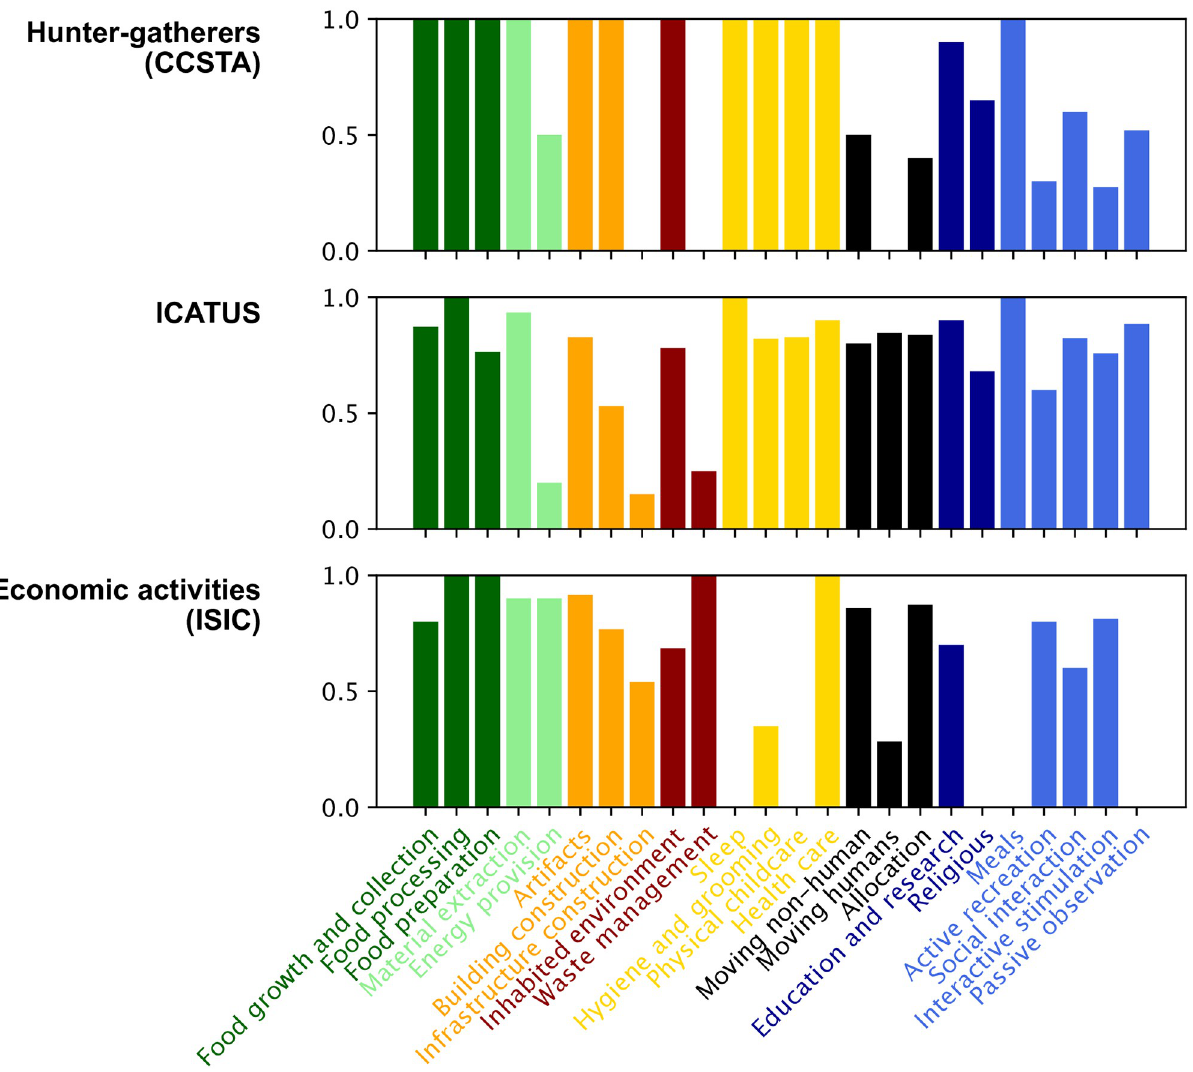
Fig 4. Average time fraction by MOOGAL category. Each bar shows the average of all time fractions associated with each category, for each of the three illustrative lexicons. Where the average time fraction is 1, only unambiguous, direct associations occurred within the category. Where the value is < 1, the association required some subdivision of activities amongst multiple categories. For example, food processing was only unambiguously associated with activities in all three lexicons, whereas infrastructure creation and maintenance was estimated as a subcomponent of at least one activity in both ICATUS and ISIC (and is entirely absent from hunter gatherers, who did not create